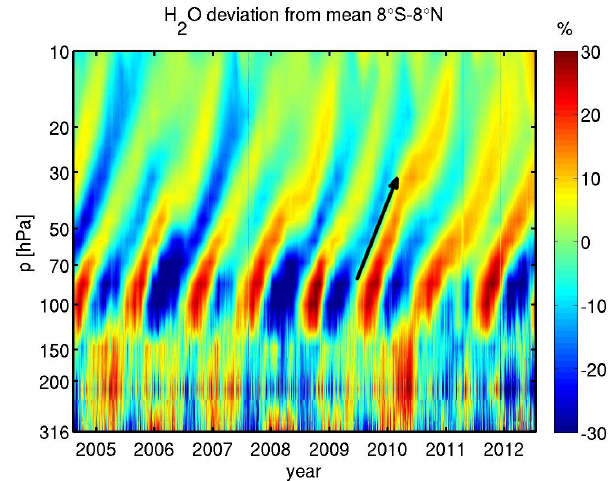
Fig. 2. The so called atmospheric tape recorder shows zonal mean H 2 O anomalies in the tropics as a function of time and altitude. Red colors show above average volume mixing ratios, blue shows lower values mainly during NH winter near 100 hPa. The seasonal cycle with an amplitude of about 30 % is imprinted at 100 hPa and slowly transported upward by the ascending branch of the BDC as indicated by the arrow. The slope of the arrow indicates the average speed of the BDC. The variability between 316 and 150 hPa is mostly due to ENSO. In El Ni˜no (La Ni˜na) years more (less) H 2 O is observed.